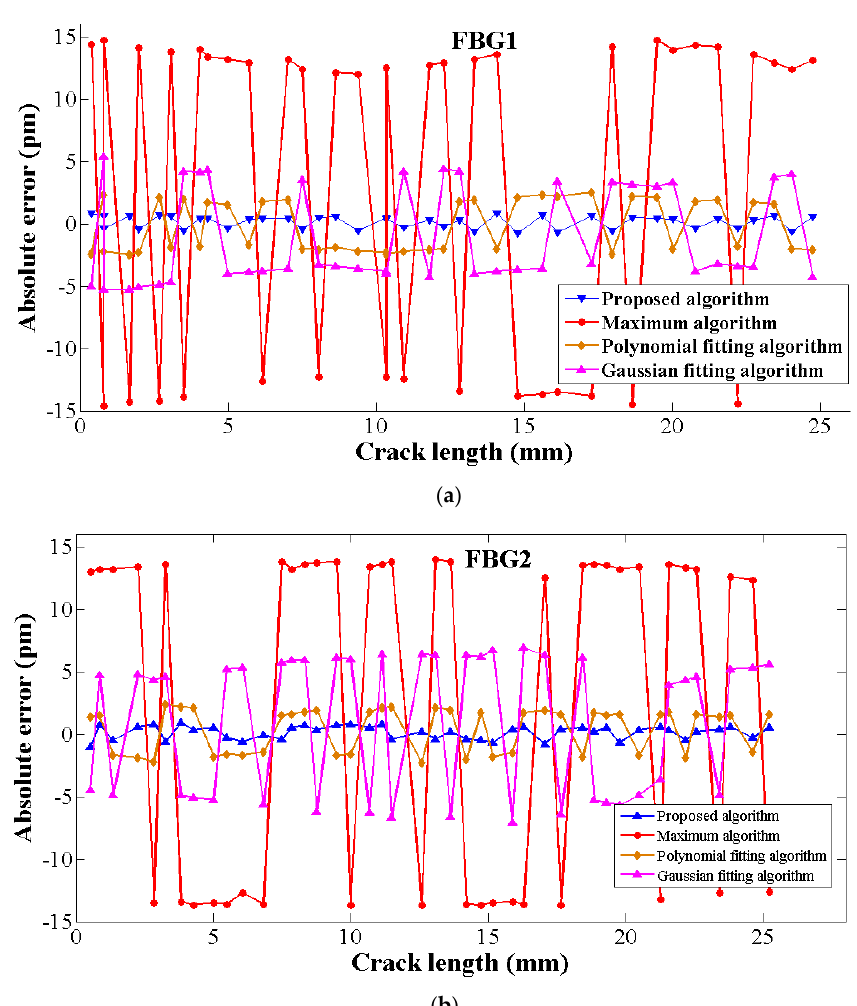
Figure 10. The absolute error of five peak seeking algorithms at different crack lengths. ( a ) The absolute error of five peak seeking algorithms in FBG1, ( b ) The absolute error of five peak seeking algorithms in FBG2.